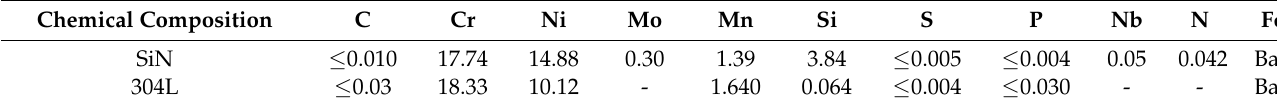
Table 1. Composition (wt.%) of SiN and 304L stainless steels used in this work. Chemical Composition